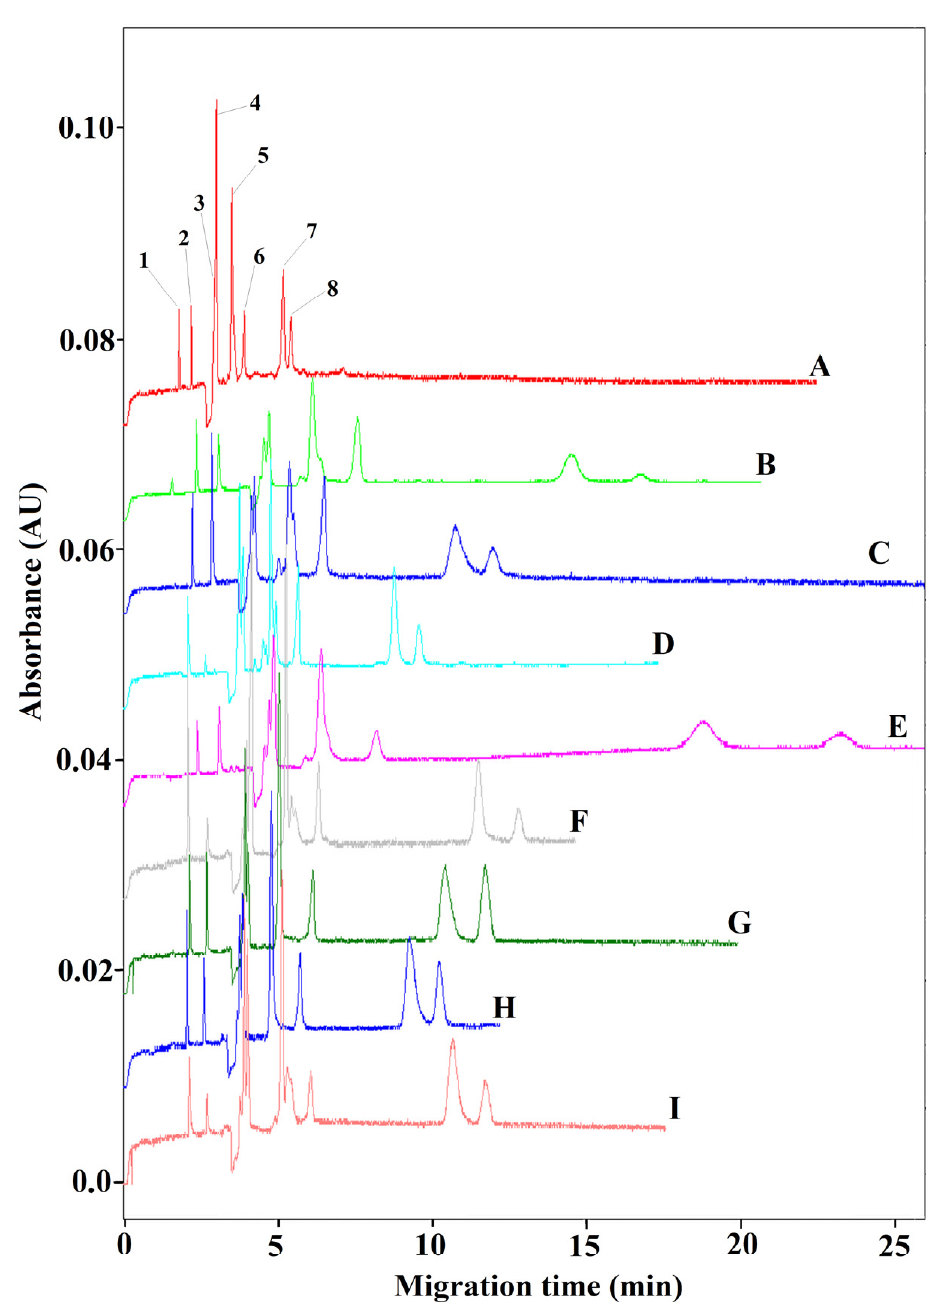
Figure 1. Separation of amino-group-containing compounds in the inner-surface-modified capillaries. Conditions: 0.05 mol/L Na 2 HPO 4 +1 mol/L HCl, pH 7.40, applied voltage 5 kV, 20 °C, normal polarity. ( 1 ) AChCl, ( 2 ) epinephrine, ( 3 ) L-Trp, ( 4 ) glutamine+A 1 , ( 5 ) L(En)+A 2 , ( 6 ) GDChA, ( 7 ) glu- tathione, ( 8 ) HIAA (A 1 and A 2 mean parts of angiotensin), injection time 3 s. ( A ) Sol–gel base, n = 3; ( B ) sol–gel + curcuma extract, n = 5; ( C ) sol–gel + Moringa extract, n = 3; ( D ) sol–gel + St. John’s wort extract, n = 7; ( E ) sol–gel + mixture 1 of extracts, n = 3; ( F ) sol–gel + curcumin, n = 3; ( G ) sol–gel + hypericin, n = 3; ( H ) sol–gel + isoquercetin, n = 4; ( I ) sol–gel + mixture 2 of specific compounds, n = 4; n , number of repeated analyses in a particular capillary.